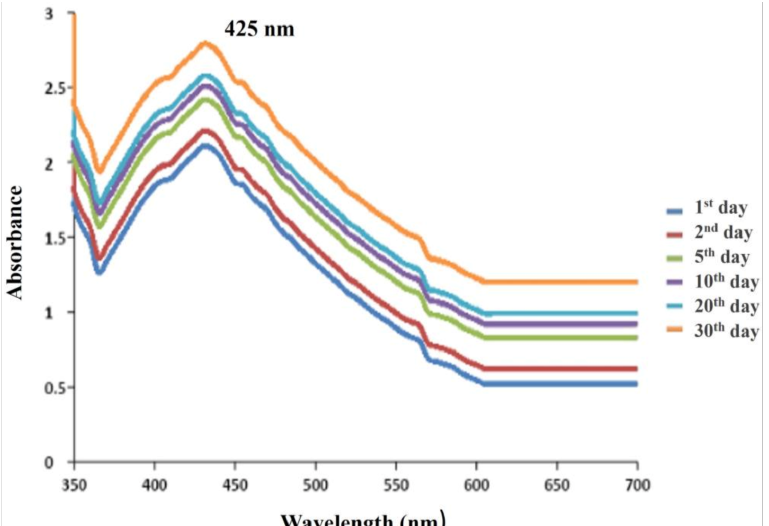
Figure 5. Comparison of the stability of synthesized silver nanoparticles on the 1st day, 2nd day, 5th day, 10th day, 20th day and 30th day, proving that the synthesis of nanoparticles using bacterial supernatant was a very compassionate and practical method for the synthesis of nanoparticles.